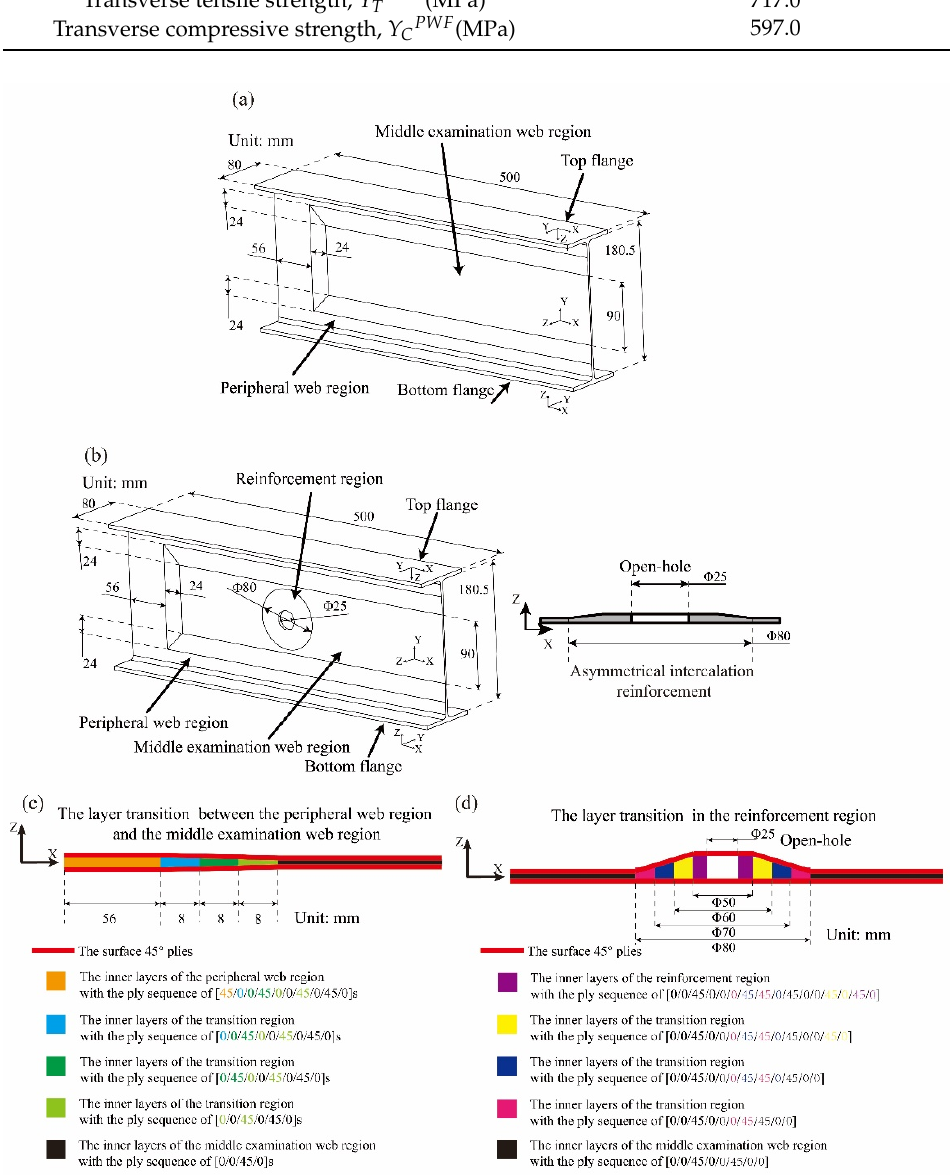
Figure 1. Configuration and dimensions of the PWF composite I-section beams: ( a ) specimens of BW-I with the web region in perfect condition; ( b ) specimens of BW-II with open-hole and asymmetrical intercalation reinforcement in the center of the web region; ( c ) the layer transition between the peripheral web region and the middle examination web region; ( d ) the layer transition in the reinforcement region of the BW-II